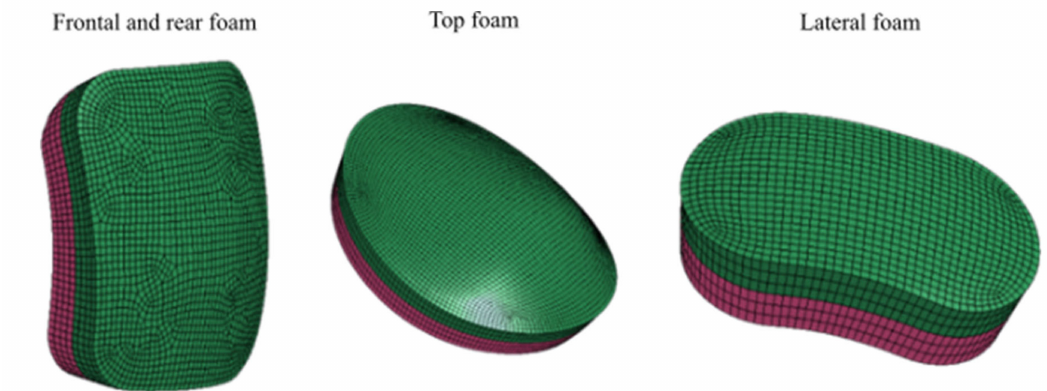
Figure 2. Finite element model of foam pads.